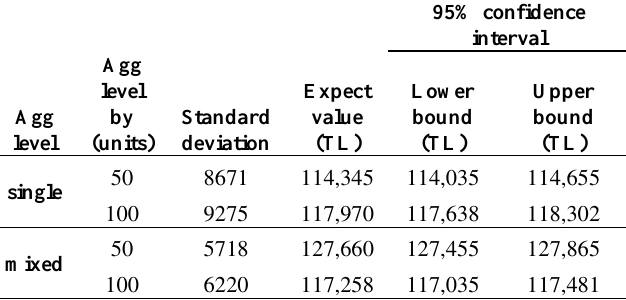
Table 2. The analysis results for each aggregation level in two product case